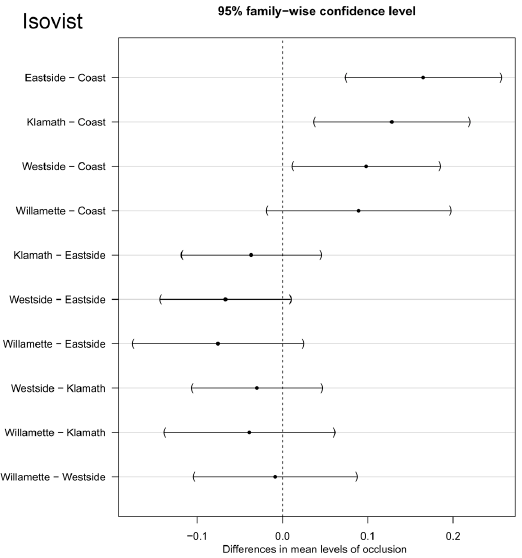
Figure 10. Example isovist polygon at differing radii. The percentage of visible area declines as the radius of the isovist is increased.